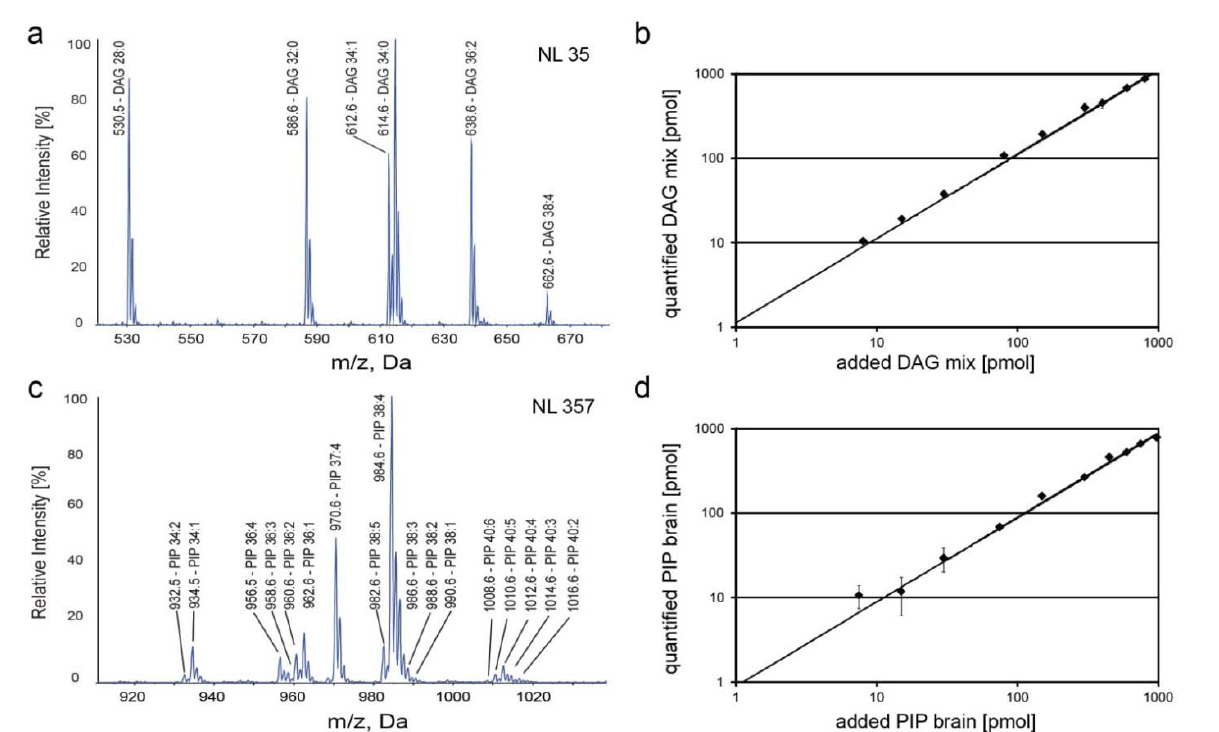
Figure 3. Identification of DAG, PIP and PIP by scanning for headgroup-specific neutral 2 losses ( a,c,e ). ( a ) Scanning for neutral losses of 35 Da enables identification of DAG species. Scanning for neutral losses of 357 Da and 437 Da allows identification of PIP brain ( e ) species, respectively. Linearity of DAG, PIP and PIP brain ( c ) and PIP 2 2 quantification ( b,d,f ); ( b ) The standard DAG 17:0/17:0 was spiked into an equimolar mixture of DAG 14:0/14:0, DAG 16:0/16:0, DAG 16:0/18:1, DAG 18:1/18:1 and DAG 18:0/20:4. Quantification was performed by MPIS; ( d ) The standard PI(4)P 17:0/20:4 was spiked into extracts of PIP brain. Quantification was performed by scanning for neutral loss brain species were quantified by scanning for neutral loss of 437 of 357 Da; ( f ) PIP 2